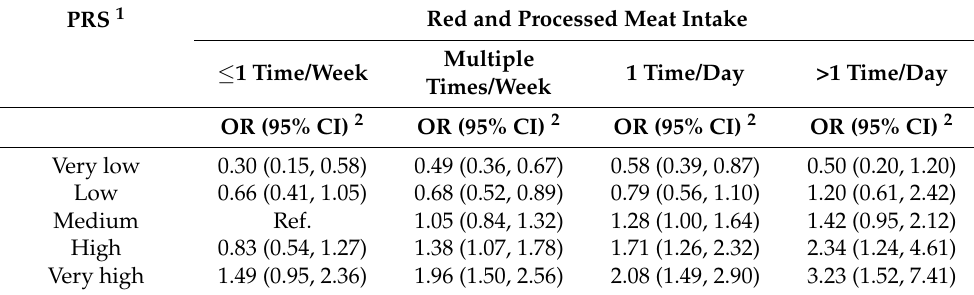
Table 4. Joint association of red and processed meat intake and polygenic risk score with colorectal cancer